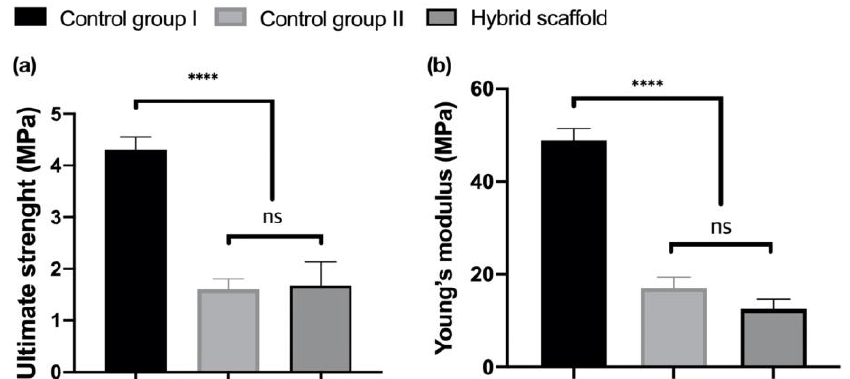
Figure 6. Analysis of the compressive test of each specimen using the ultimate strength ( a ) and Young’s modulus ( b ) (ns: not significant, **** p < 0.0001).